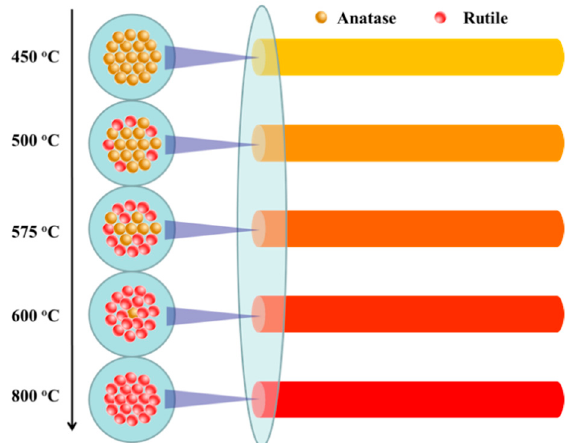
Figure 4. Schematic diagram of the phase transition of TiO 2 nanofibers calcined at different